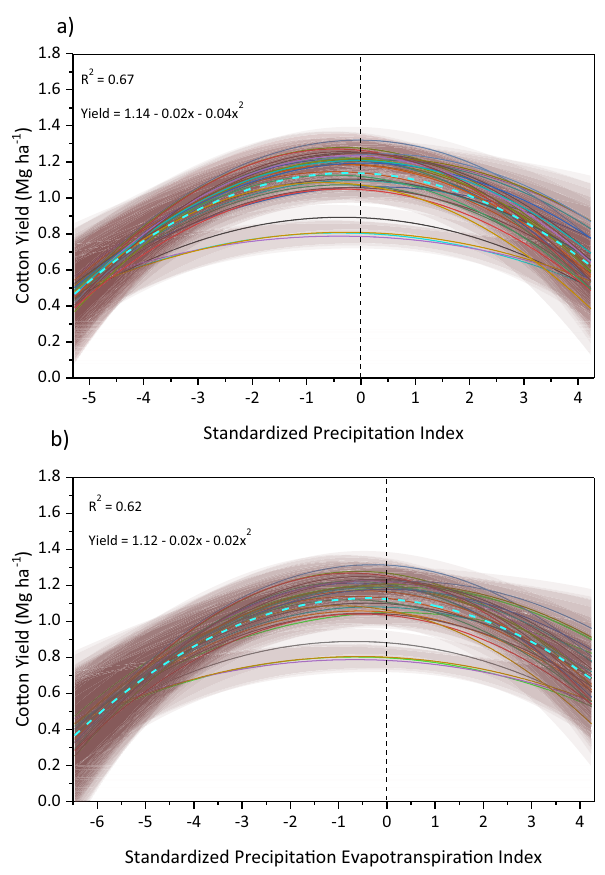
Fig. 2 Quadratic relationships between drought severity and detrended cotton yield during the growing seasons for the 32 management systems. The drought severity is represented by a standardized precipitation index (SPI) and b standardized precipitation evapotranspiration index (SPEI). The arched dashed line represents the relationship between mean cotton yield and drought severity. The shaded band around curves represent the 95% con fi dence